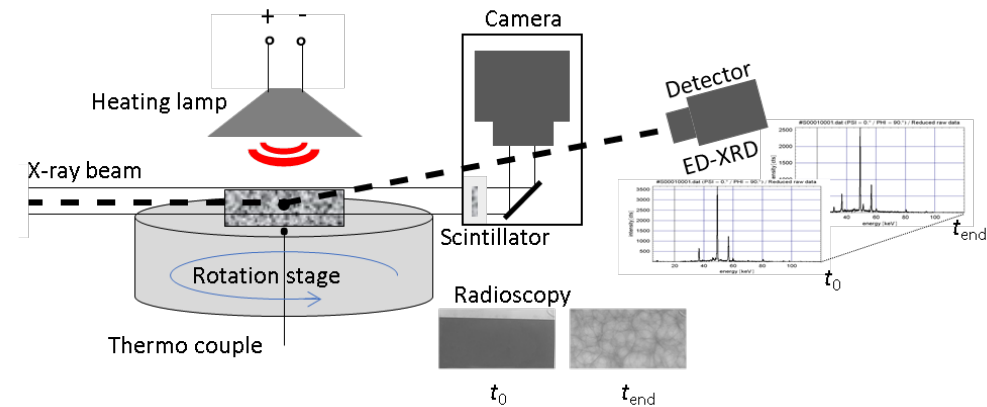
Figure 1. Schematic view of the experimental setup for simultaneous X-ray radioscopy and measurements during foaming of samples at the Energy Dispersive Di ff raction (EDDI) beamline, Bessy diffraction measurements during foaming of samples at the Energy Dispersive Diffraction (EDDI) II, Berlin, beamline, Bessy II, Berlin, Germany.